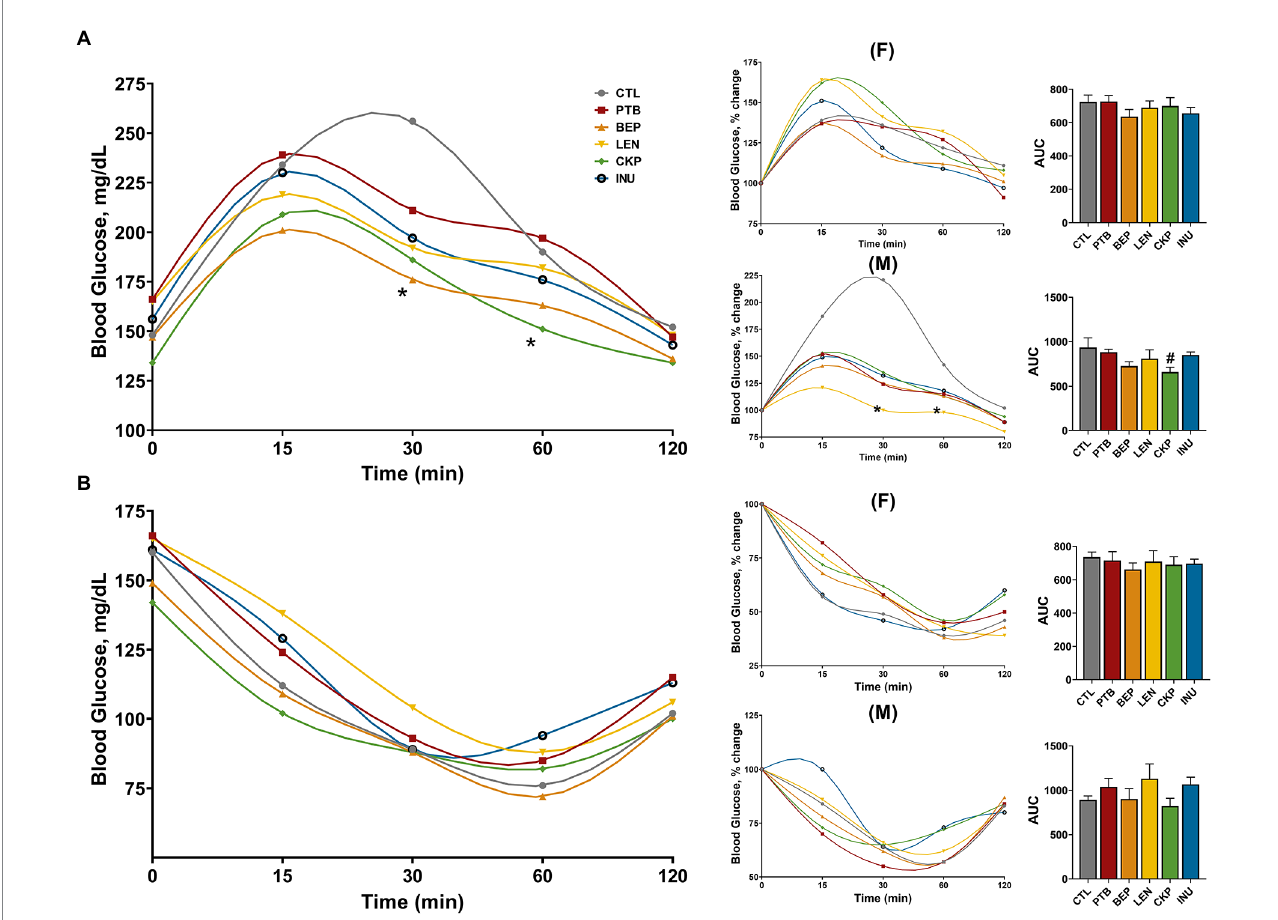
FIGURE 5 Effect of resistant starches from dietary pulses on post-prandial blood glucose levels and insulin sensitivity. (A) Meal tolerance test and (B) Insulin tolerance test in combined or separately in males and females along with sex-specific percent change in blood glucose levels and area under curve (AUC). PTB, Pinto beans; BEP, black-eyed peas; LEN, Lentils; CKP, chickpeas; INU, inulin; CTL, control high-fat diet group. # p < 0.1, * p <